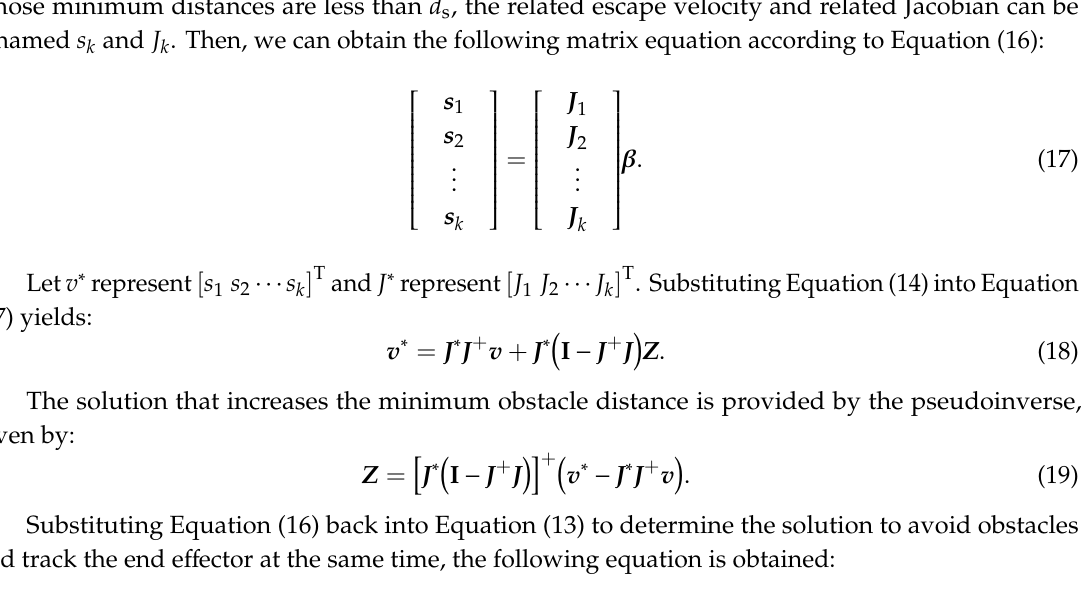
( c ) Figure 15. Curves of the low-contact impact trajectory: ( a ) Displacement, ( b ) Velocity, and ( c ) Acceleration.